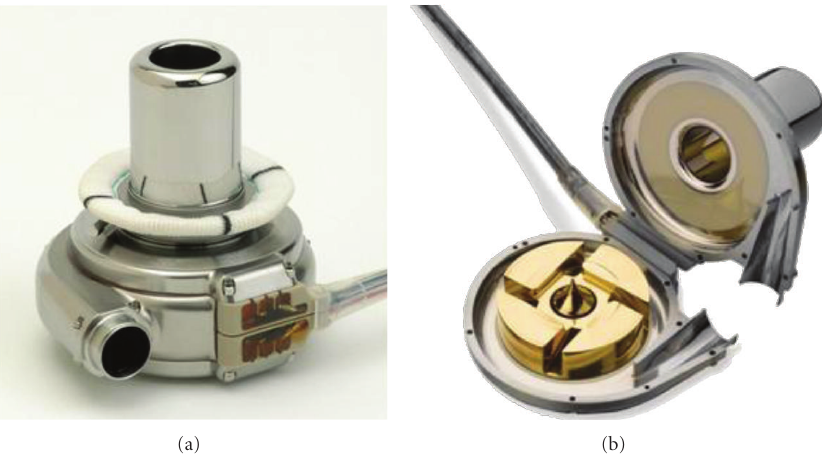
Figure 3: External (a) and internal (b) view of third-generation continuous-flow rotary left ventricular assist device HVAD (HeartWare). Reprinted with permission from HeartWare.